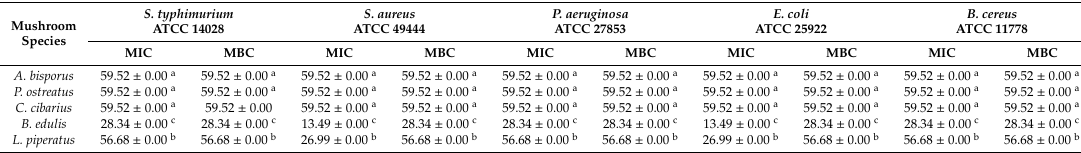
Table 4. MICs and MBCs of mushroom extracts (mg / mL) against five di ff erent microorganisms by broth microdilution